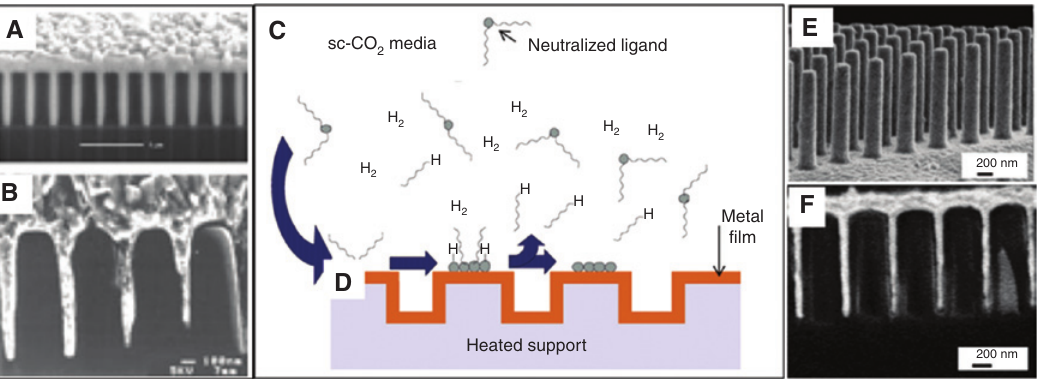
Figure 4: Conformal Cu film deposition onto etched Si support via the cold wall reactor method. (A, B) Complete filling with Cu of high-aspect- ratio features of < 100 nm in width; (C, D) sketch of H -assisted metallization in sc-CO ; (E) Au pillars and (F) Au films deposited onto etched 2 2 silicon wafers. Reprinted with permission from Zong Y, Watkins JJ, Chem. Mater. 2005, 17, 560–565 [43], Copyright 2005 American Chemical Society; and from Cabañas A, Long DP, Watkins JJ, Chem. Mater. 2004, 16, 2028–2033 [44], Copyright 2004 American Chemical